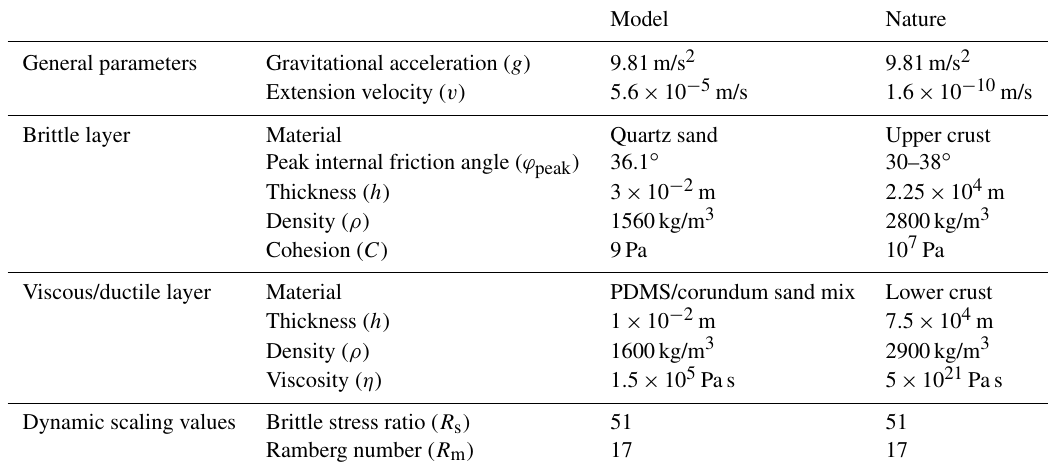
Table 3. Scaling